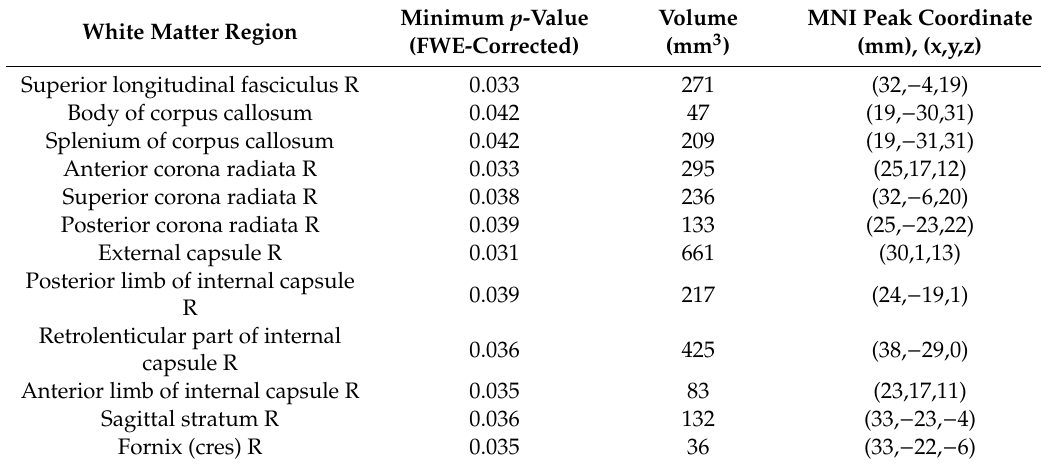
Table A3. White matter regions from the ICBM-DTI-81 White Matter Atlas for which significant decreased FA values were found in CM compared to HC including the time from onset of CM as a covariate.